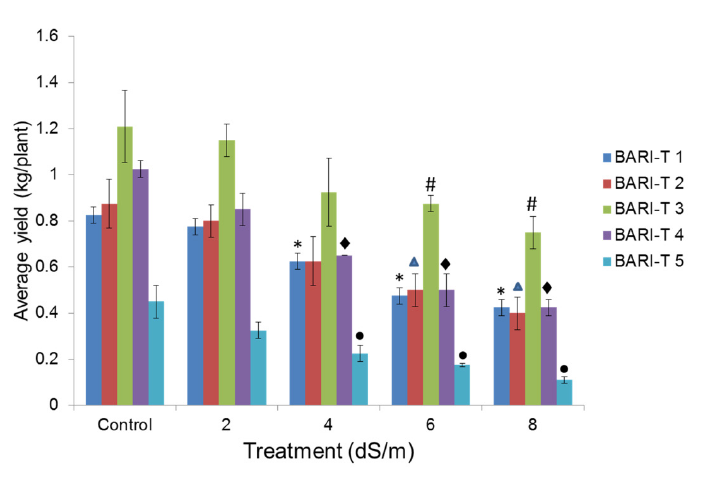
Fig. 7. Effects of NaCl-salinity yield in five BARI-T plants. Error bars indicate mean ± SD (n=3). Asterisk *, , #, ♦ , and • denote a significant difference between the saline-treated group and control group of BARI-T 1, BARI-T 2, BARI-T3, BARI-T 4 and BARI-T 5, respectively at